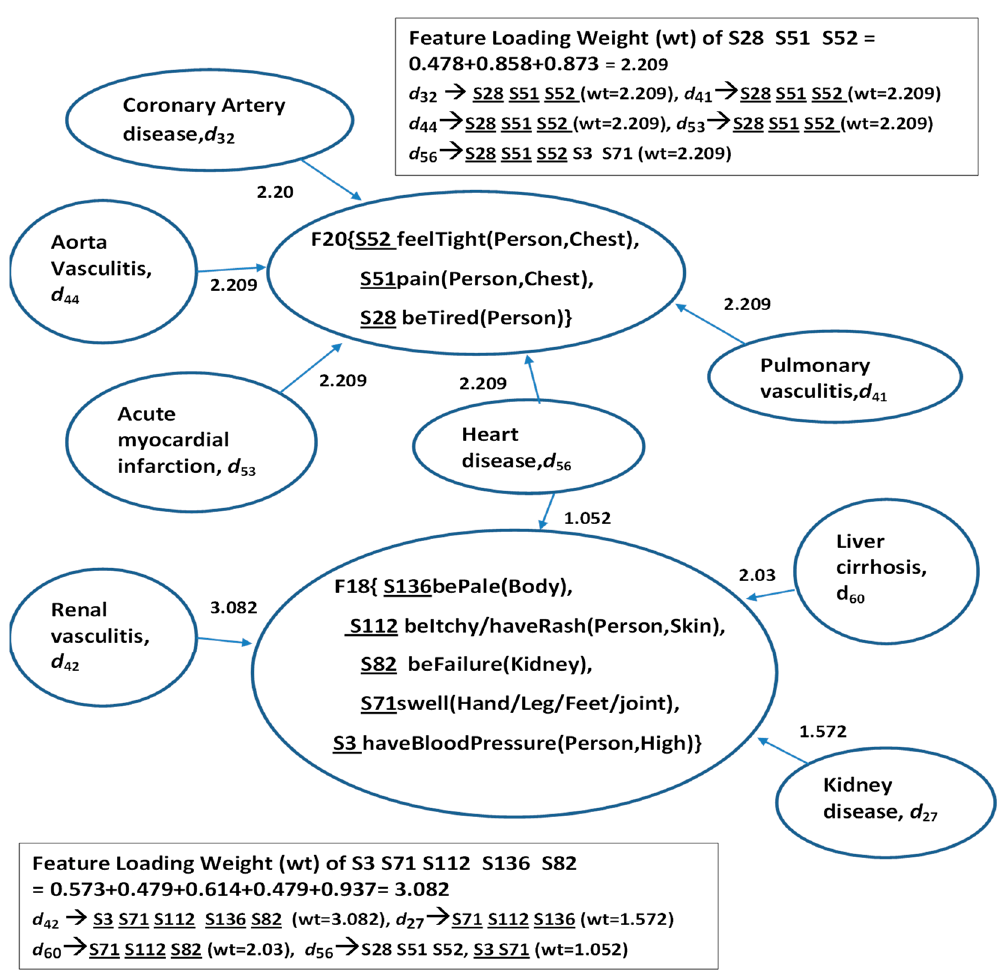
Figure 7. Show DSKG with each arrow being CErel which connects d i to Factor z (or F z ), e.g., Factor18/F18 and Factor20/F20 containing some common s c features represented by the underlined s c .